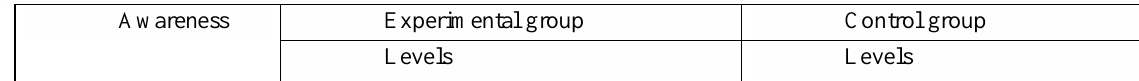
Table 2. Research methodology of educational research typology. Level of educational research